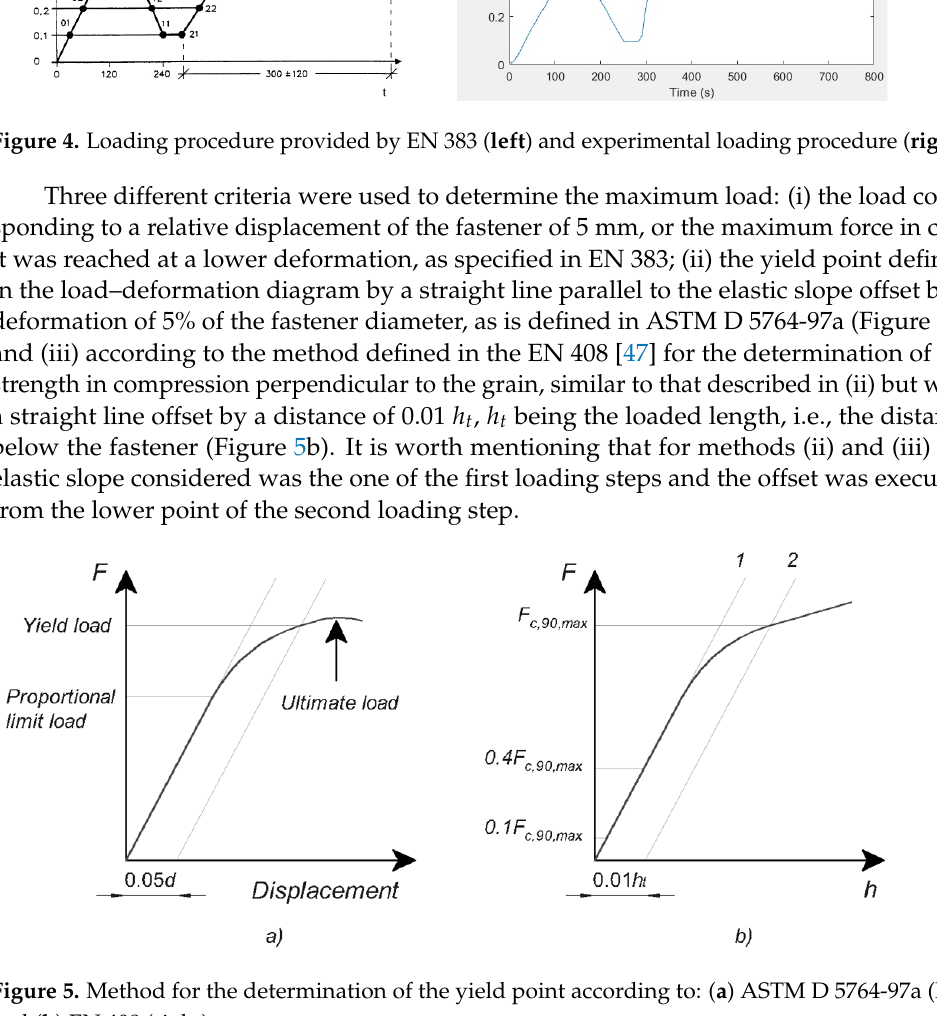
Figure 4. Loading procedure provided by EN 383 ( left ) and experimental loading procedure ( right ). The embedment strength was determined according to Equation (1), and charac- 𝑓𝑓 ℎ